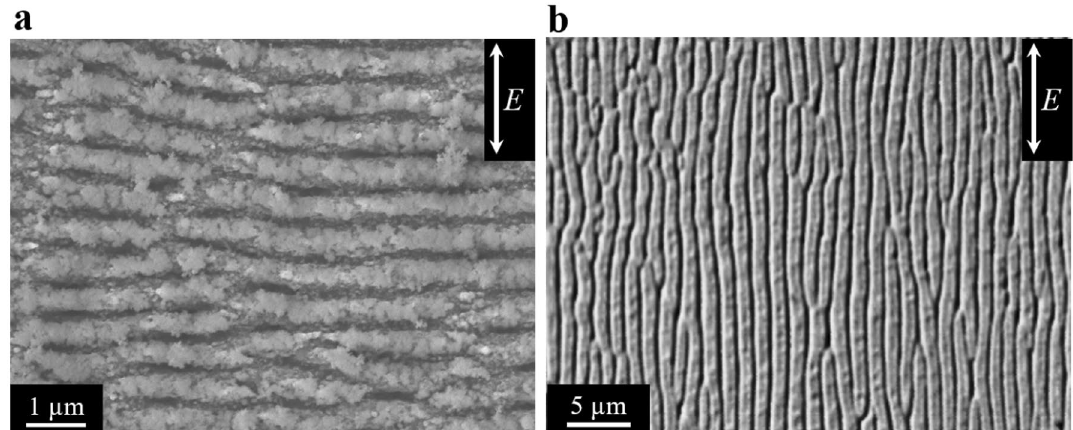
Figure 2. Surface SEM images of LIPSS formed using ( a ) Ti:Sapphire laser and ( b ) MIR-FEL. LIPSSs were formed perpendicular in the case of Ti:Sapphire laser and parallel in the case of MIR-FEL to the direction of the laser polarization, which is represented as E in the figure. The periods of the LIPSS were approximately 582.5 ± 35 nm and 1.09 ± 0.35 μm, respectively.